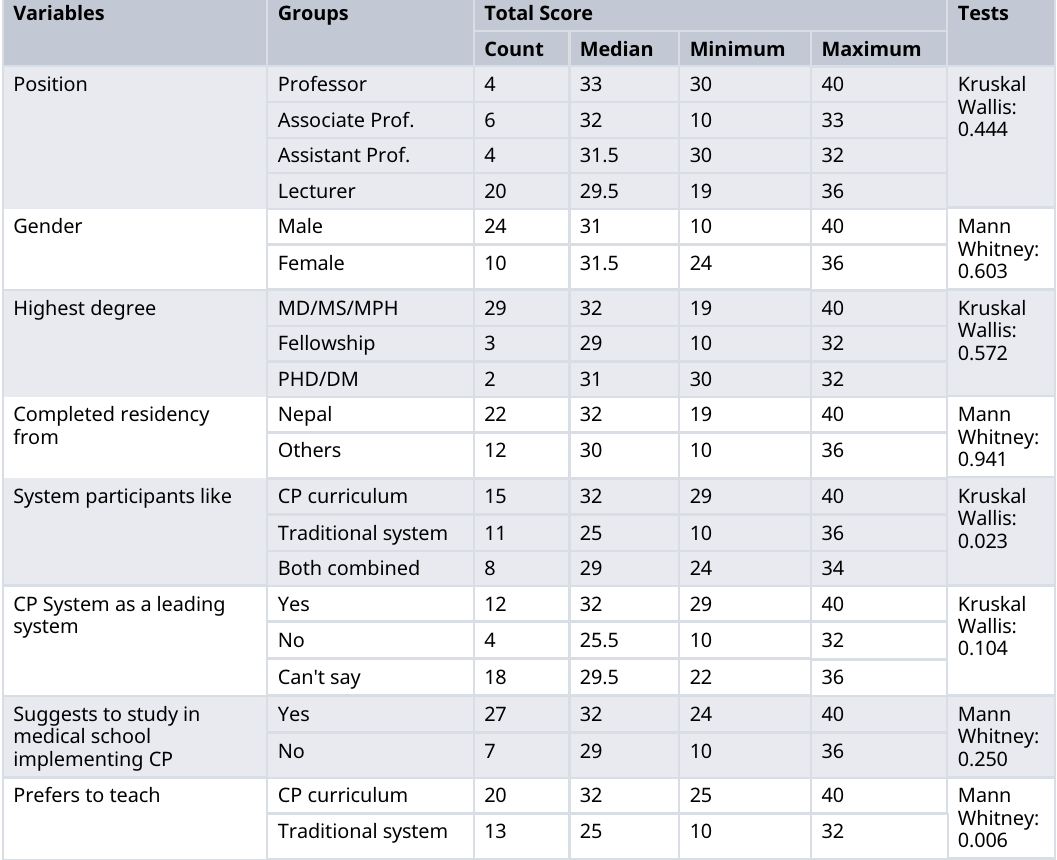
Table 1. Comparison of demography of the faculty based on forced Likert scale total scores of perception questionnaire for faculty. Variables Groups Total Score Tests Count Median Minimum Position Kruskal Wallis: